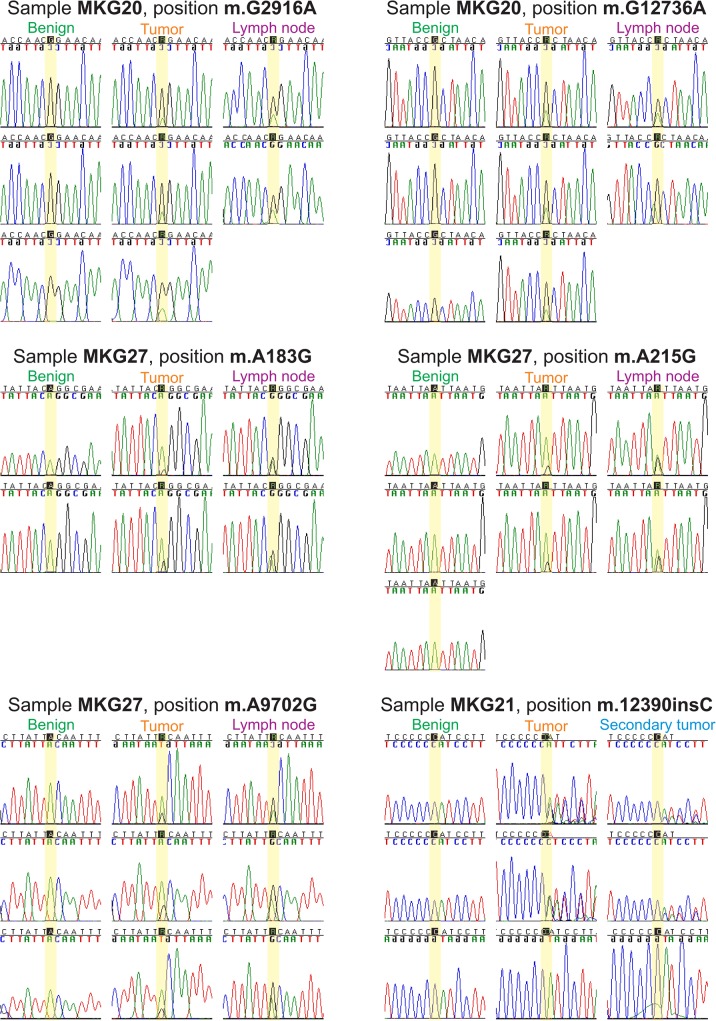
Heteroplasmic mutations as seen with Sanger sequencing in MKG20, MKG21 and MKG27.The benign tissue was taken from the resection border of the tumor.